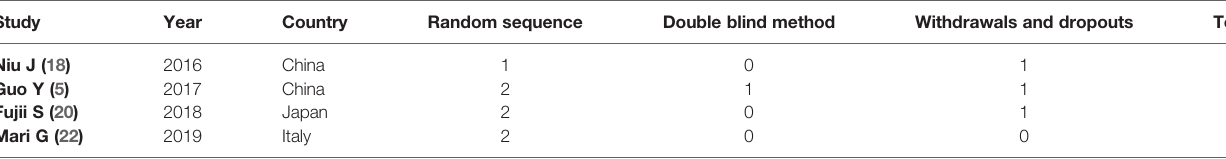
TABLE 2 | Bias risk in the randomized controlled trials as assessed by the Jadad scoring system.